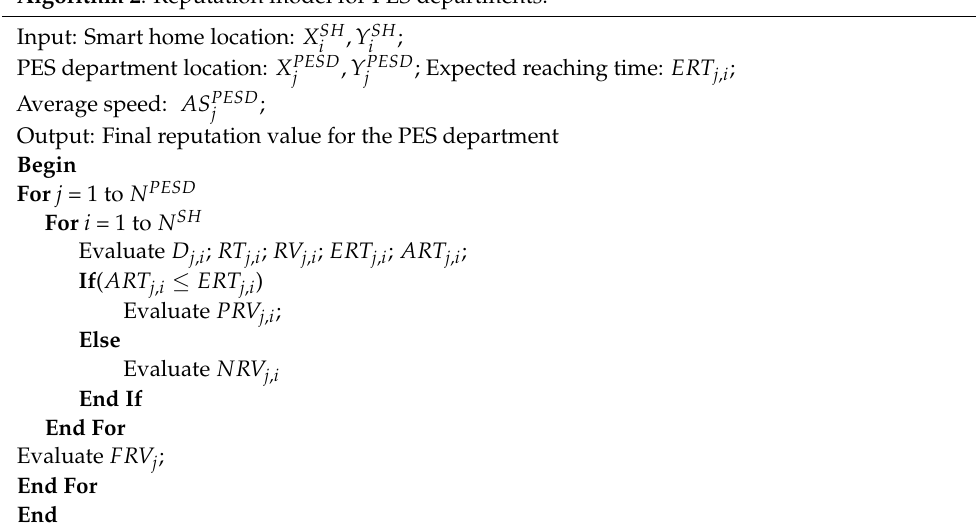
Algorithm 2 : Reputation model for PES